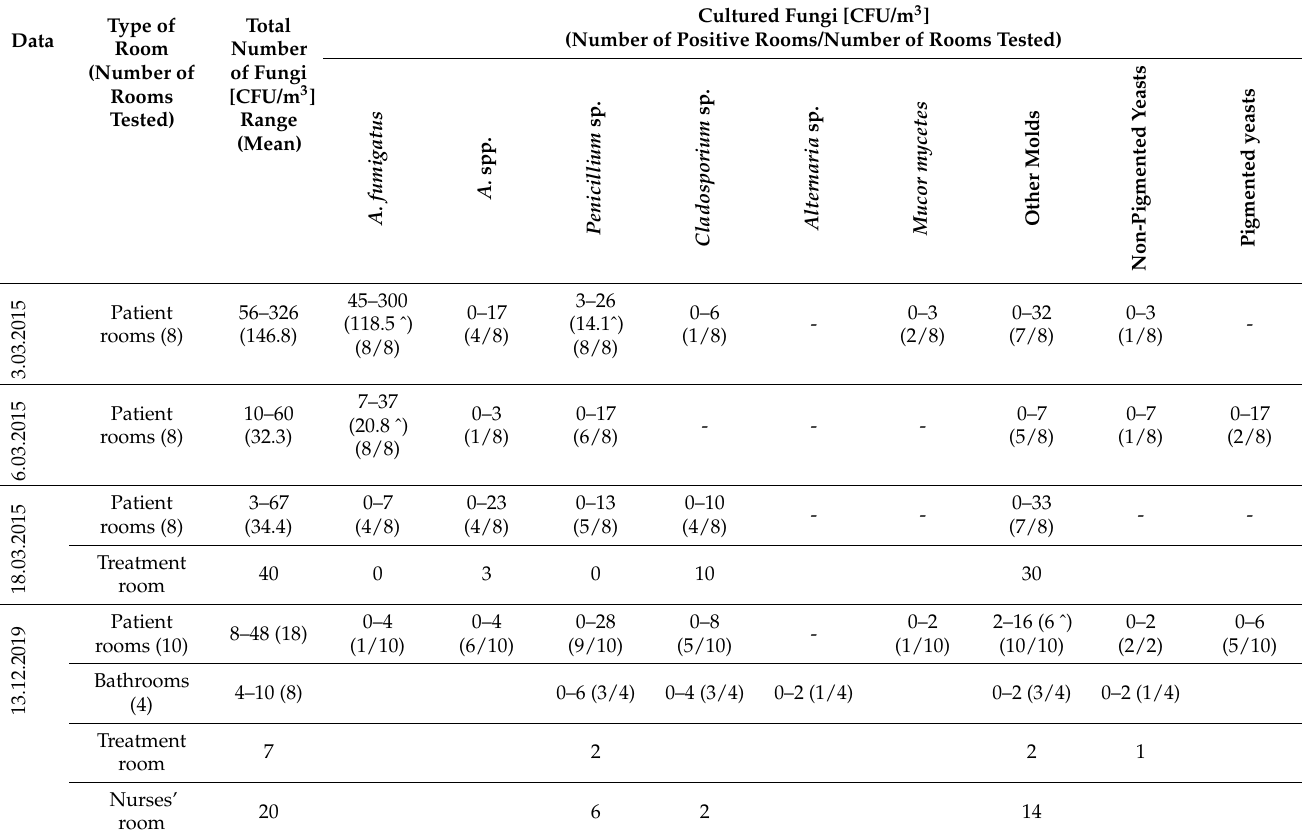
ˆ—a mean value of CFU/m 3